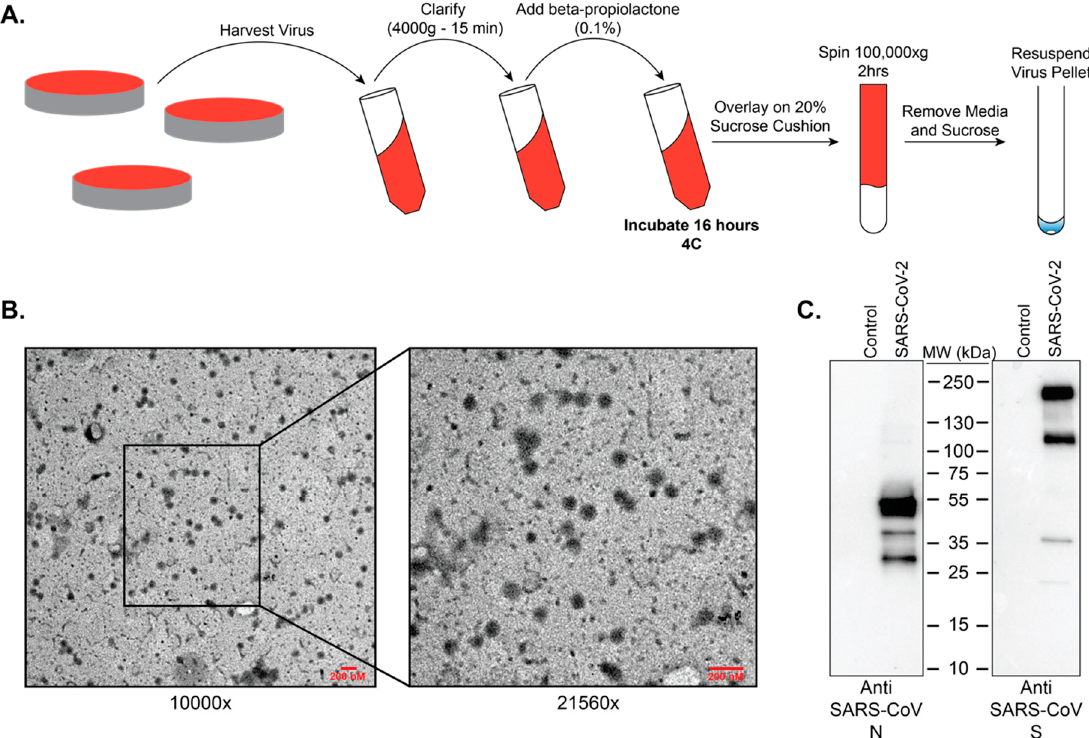
Figure 4. BPL inactivation and purification of SARS-CoV-2 virus particles. ( A ) Graphical depiction of the workflow established for the inactivation and purification of BPL inactivated SARS-CoV-2. ( B ) Negative stain transmission electron microscope (TEM) images of SARS-CoV-2 virus particles after purification from cell culture media over a 20% sucrose cushion at 100,000 × g for 2 h. Scale bars represent 200 nM. ( C ) Western blots of BPL inactivated virus particles for SARS-CoV-2 nucleoprotein and spike protein.